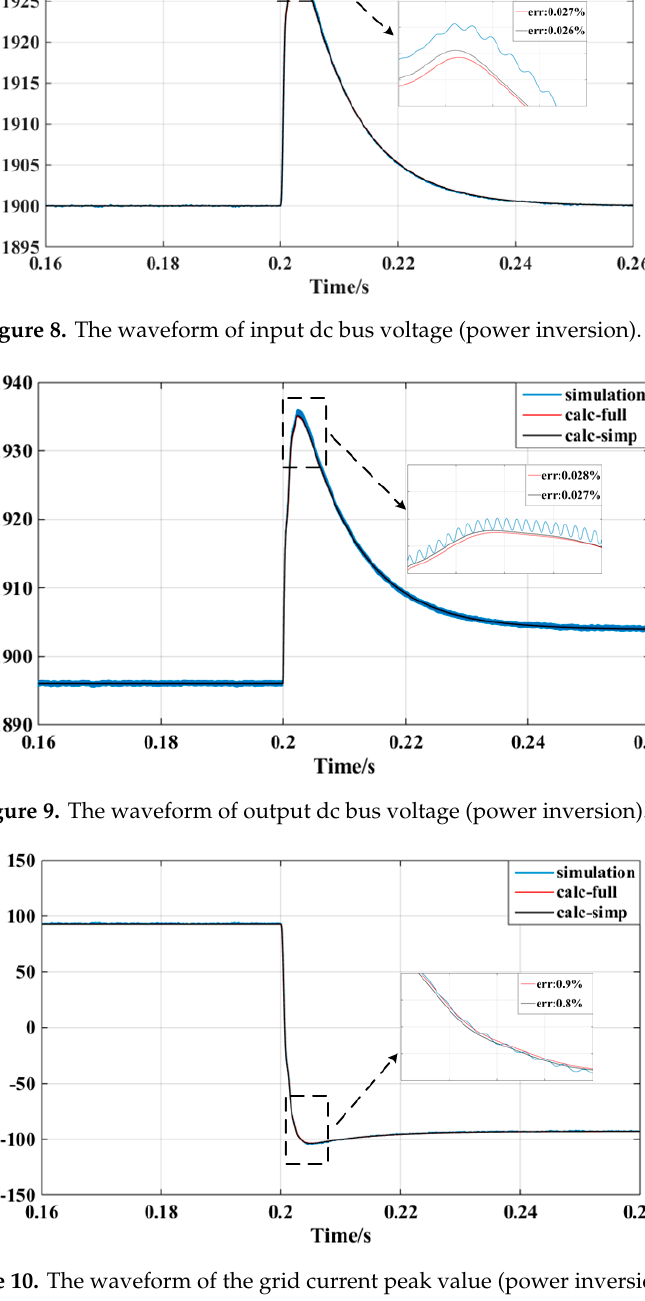
Figure 10. The waveform of the grid current peak value (power inversion).